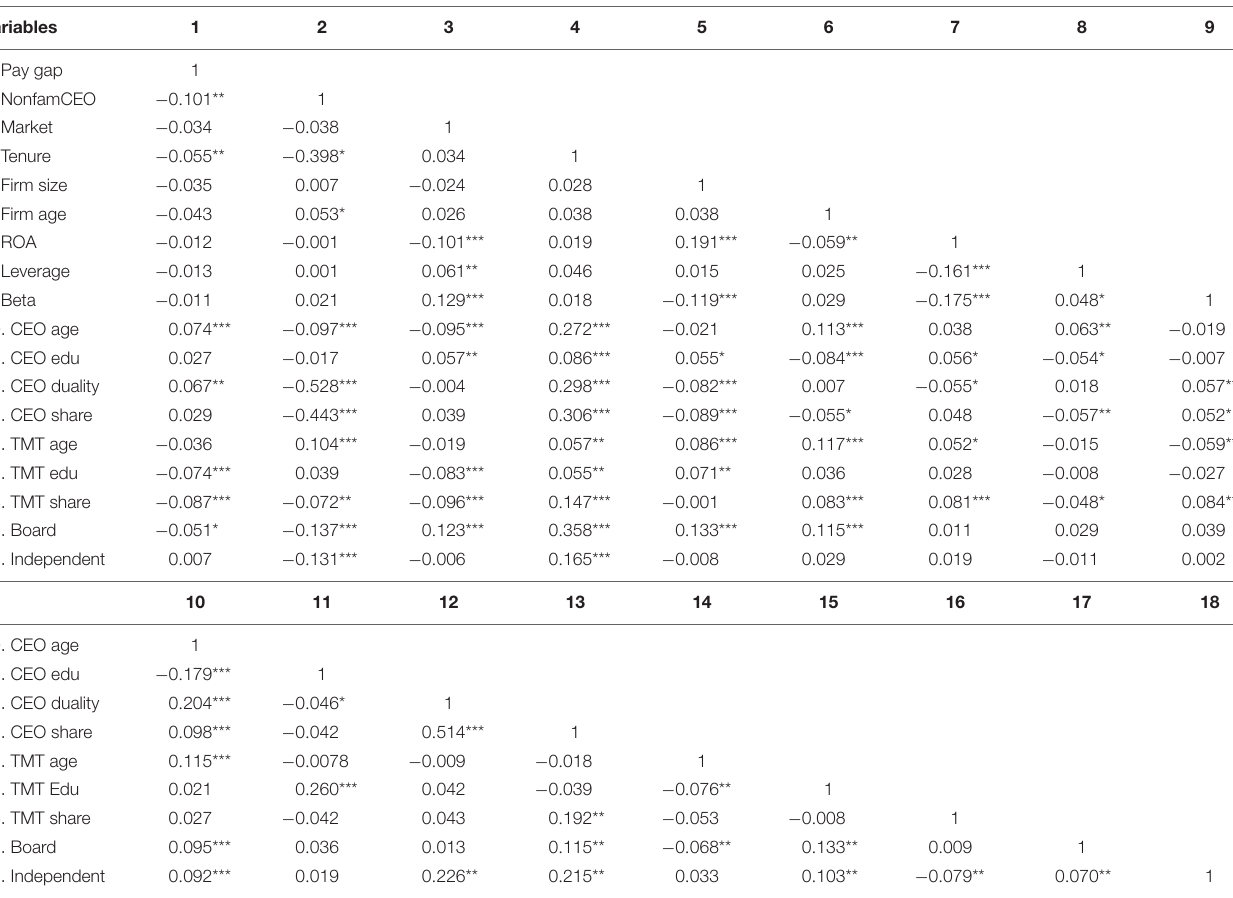
TABLE 3 | Correlation analysis (* P < 0.1, ** P < 0.05, and *** P < 0.01).